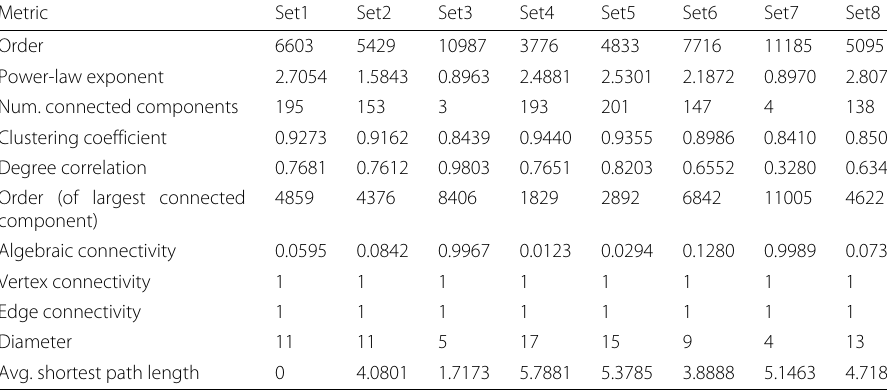
Table 10 Single-point structural network metrics for Name extraction datasets